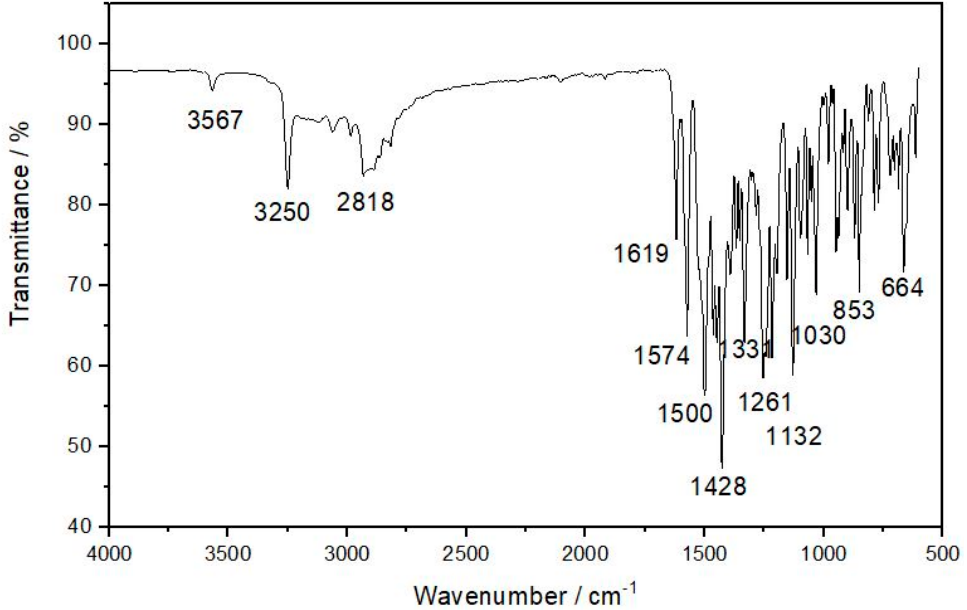
Figure A2. Erlotinib infrared spectrum.